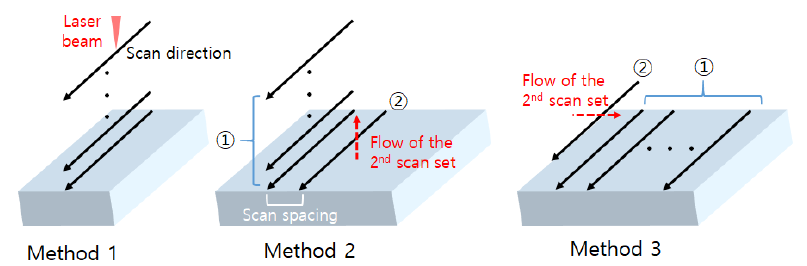
Figure 2. Multiple scanning methods. Method 1 indicates multiple laser scans with zero-scan spacing. Methods 2 and 3 are for multiple laser scans with non-zero scan spacing. In methods 2 and 3, ① and ② denote a scan sequence ( ① is the first part of the scan sequence).